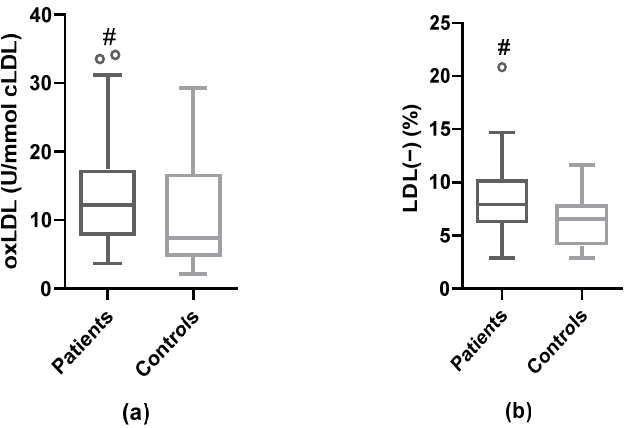
Figure 2. Concentration of oxLDL and LDL( − ) levels compared to controls. ( a ) Levels of serum oxLDL measured by ELISA in patients and controls. ( b ) Plasma LDL( − ) proportion quantified by anion-exchange chromatography in patients and controls. # vs. controls; p < 0.05.